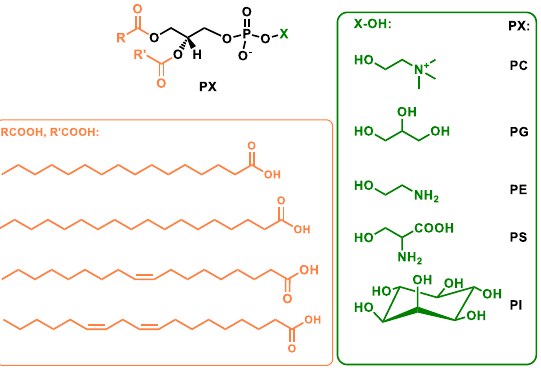
Figure 1. Structure of the main natural phospholipids (PLs) (PC: phosphatidylcholine; PG: phosphatidylglycerol; PE: phosphatidylethanolamine; PS: phosphatidylserine; PI: phosphatidylinositol).